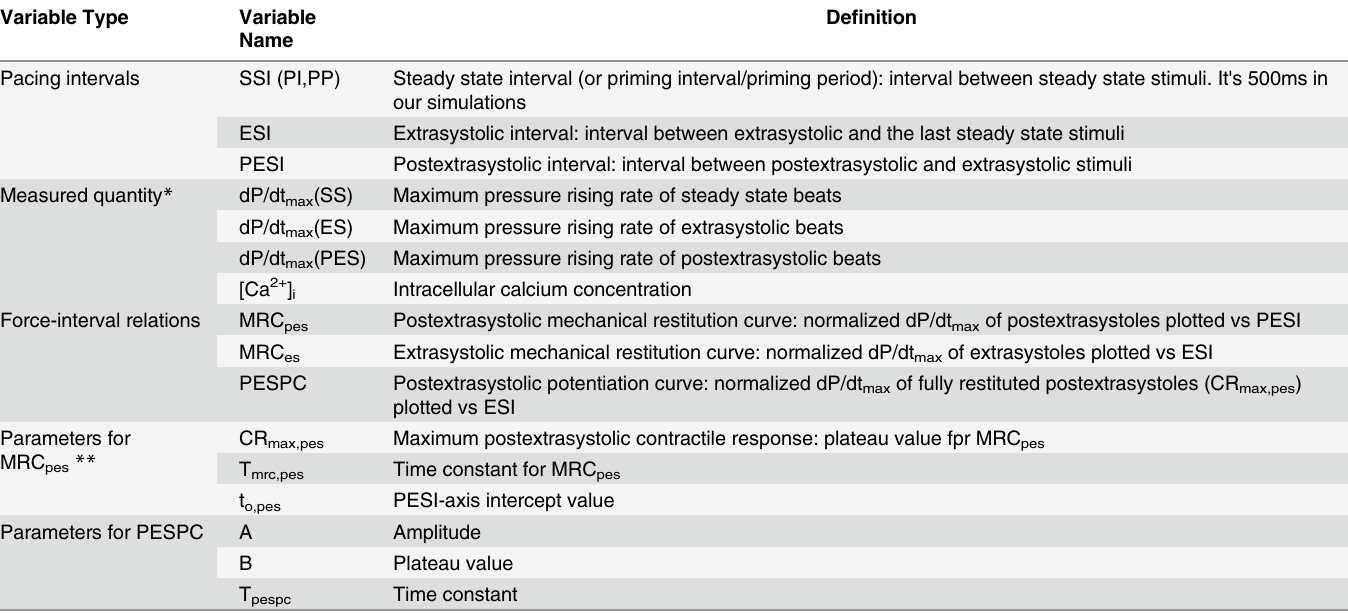
Table 1. Terminology: definition of